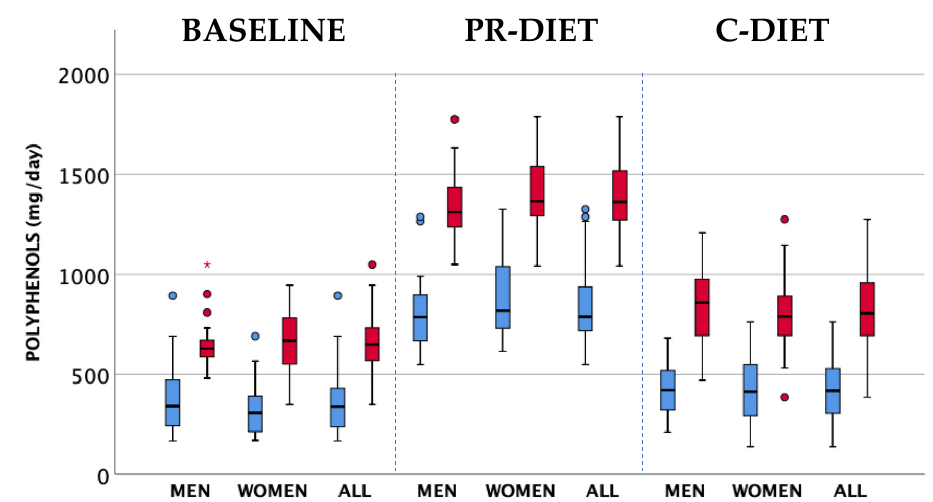
Figure 2. Polyphenol intake at baseline and in polyphenol (PR)-diet and control (C)-diet in the whole group of subjects and stratified by gender. The intake has been estimated using the PE and USDA databases and other published data (TP in light blue) and by Folin–Ciocalteau data as reported in the PE database and other sources (TPC in red). Dots represent mild outliers that are more extreme than Q1 − 1.5 * IQR or Q3 + 1.5 * IQR but are not extreme data. Asterisks are extreme data that are more extreme